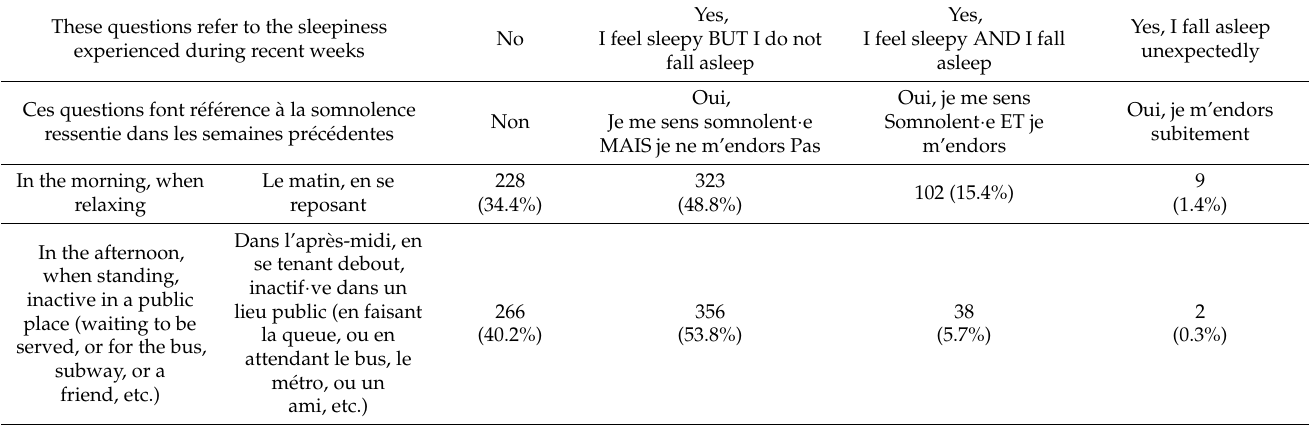
Table 1. French translation and description of the Barcelona Sleepiness Index ( n =